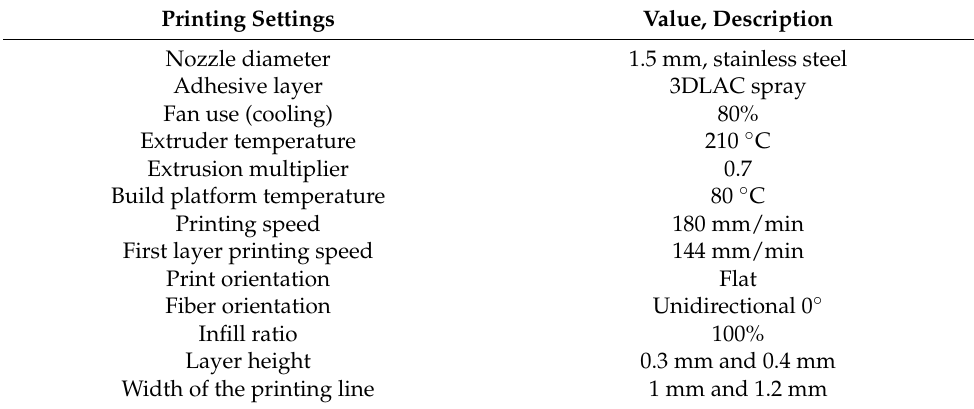
Table 1. Printing parameters.